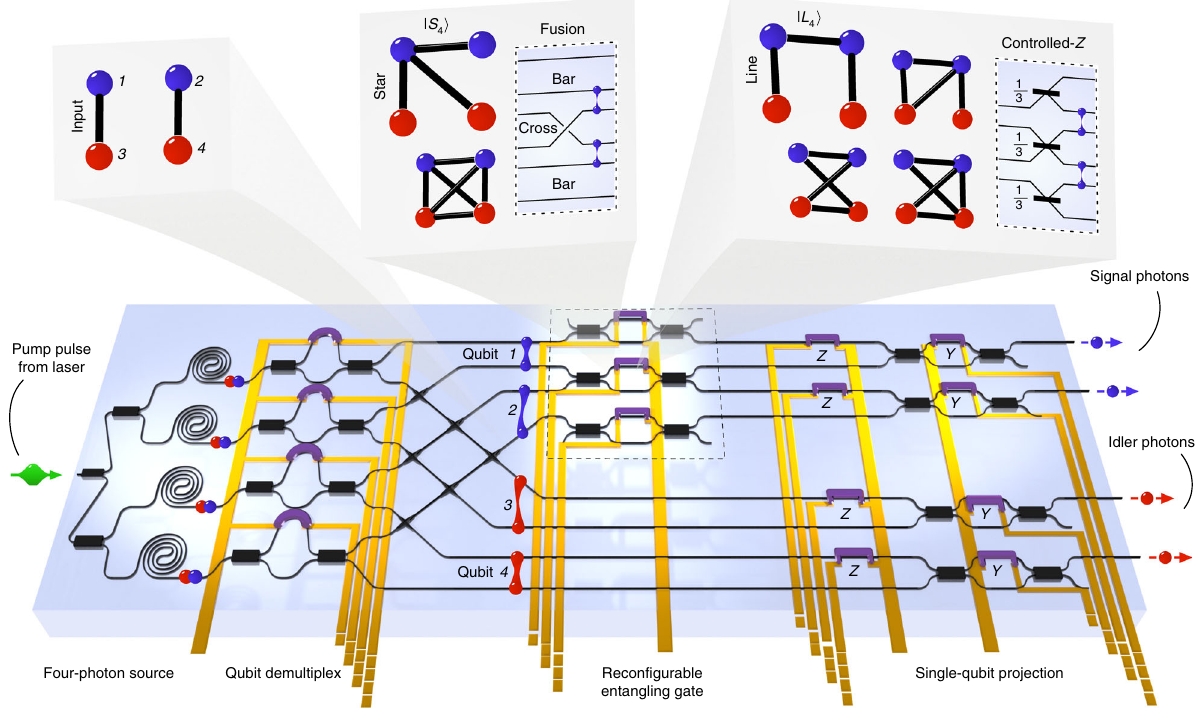
Fig. 1 Experiment overview. A schematic of the silicon-on-insulator chip-scale device is shown, comprising: four telecommunications-band photon-pair sources, producing four photons in superposition; a qubit demultiplexer, which con fi gures that superposition into a product of two Bell-pairs; a recon fi gurable postselected entangling gate (R-PEG); and four single-qubit projection and analysis stages, formed of four Mach – Zehnder interferometers implementing qubit Y rotations, preceded by four Z rotations. An optical micrograph of the device can be found in Supplementary Fig. 1. Corresponding graph states are indicated above, starting with the two input Bell-pairs, and ending with either ‘ star ’ or ‘ line ’ graph states, for fusion or controlled- Z R-PEG con fi gurations,